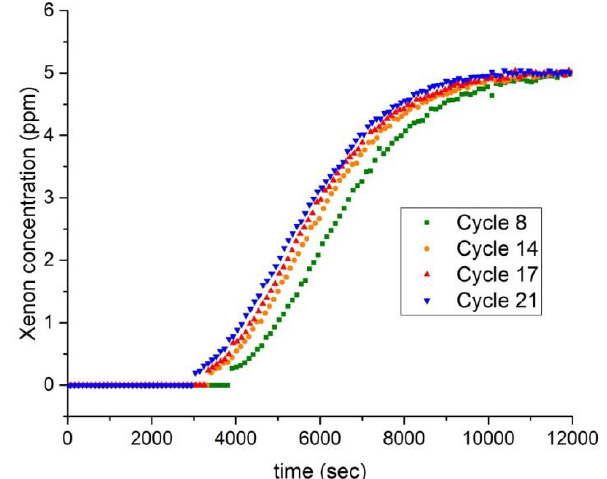
Figure 8. Breakthrough curves obtained at different cycles (room temperature) for a gas mixture containing 5 ppm of xenon in nitrogen with 10 ppb each of 1,1,1-trichloroethane, tetrachloromethane, and tetrachloroethylene. The flow rate is 80 mL/min, while the adsorbent mass is around 0.3 g.